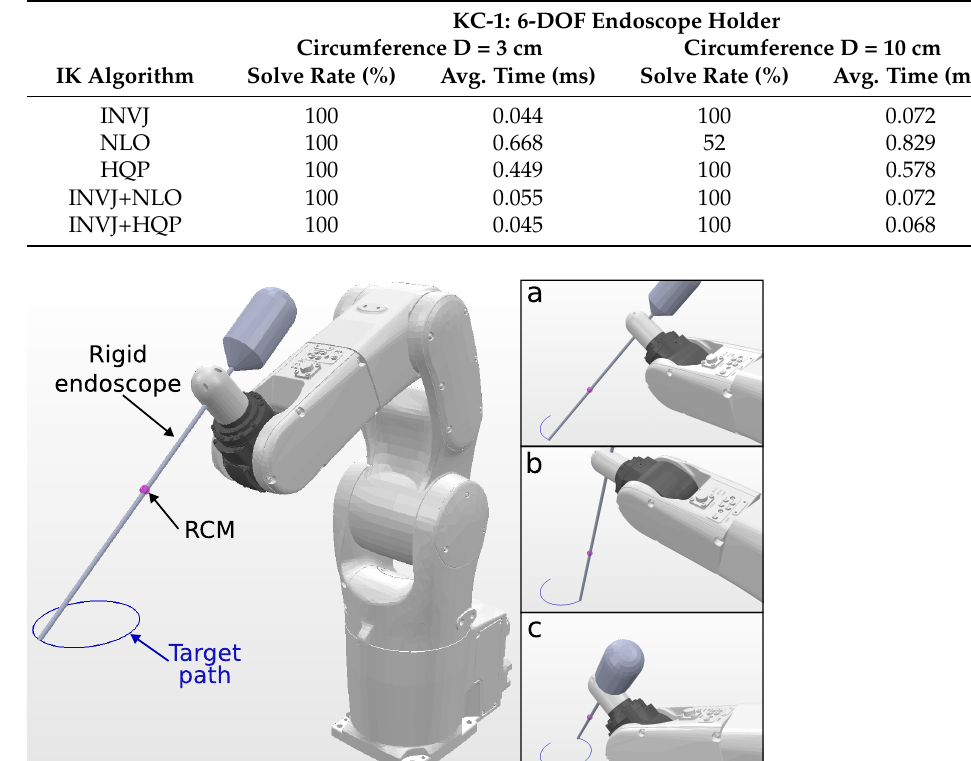
Figure 4. Simulation environment for KC-1 (endoscope holder) tracking a 10 cm circular path. The trajectory followed by the endoscope tip is visualized in blue, and snapshots ( a – c ), shown on the right, depict the robot executing the tracking task at different trajectory steps.